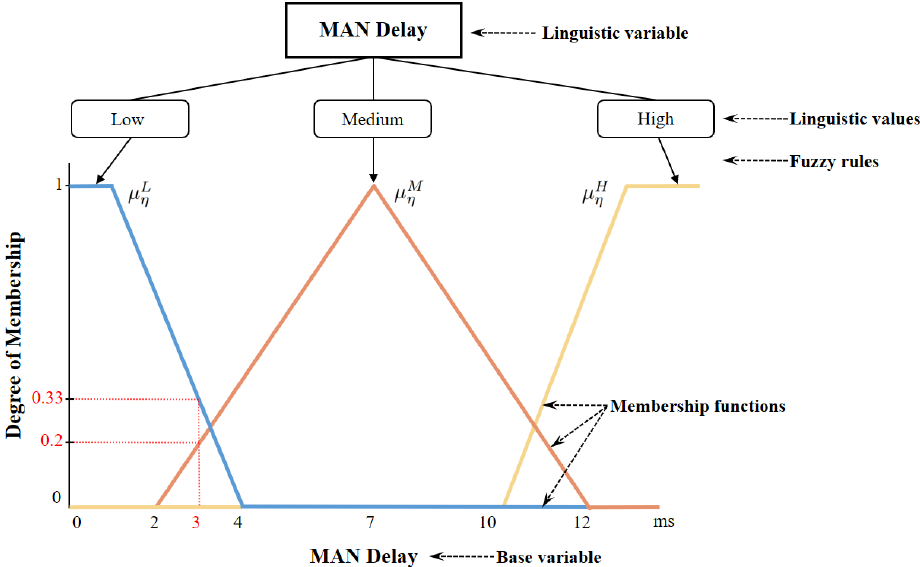
Figure 5. Example of a linguistic variable and its related